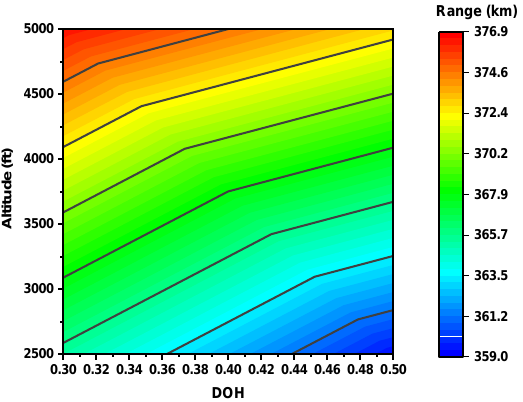
Figure 11. Hybrid electric altitude vs. DOH range comparison: 10 kg cases only ((ICE-only cruise).